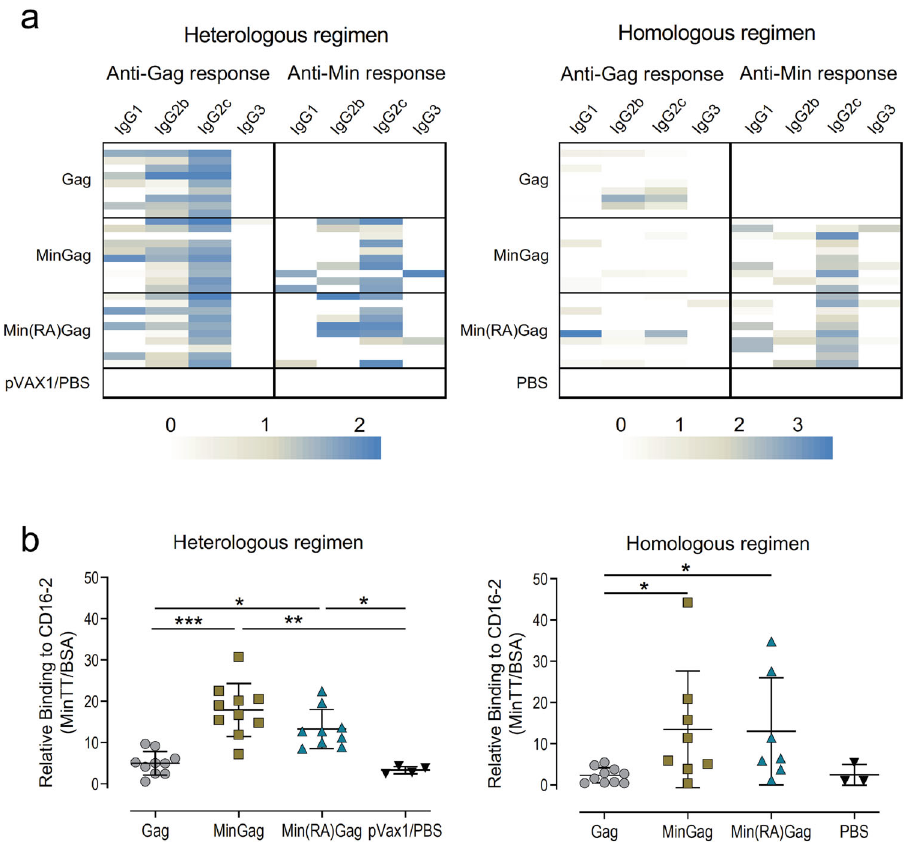
Fig. 4 Functional properties of VLP-induced humoral responses. Serum samples at week 12 from C57BL/6JOlaHsd mice vaccinated with heterologous (left panels) or homologous (right panels) regimens consisting of Gag-VLPs (grey; n = 10), MinGag-VLPs (gold; n = 10), Min(RA) Gag-VLPs (blue; n = 10) and pVAX1/PBS or PBS controls (black, n = 4). a Heatmaps of the predominant murine IgG subclasses (IgG1, IgG2b, IgG2c, or IgG3) for both anti-Gag and anti-Min humoral responses in both vaccination regimens. Each line represents one animal. b Binding to mFc γ RIV/CD16-2 by Min-speci fi c antibodies in serum from VLP-immunised mice collected at week 12. Data represented as mean ± SD of relative binding, this being the absorbance values of CD16-2 binding of each serum sample against Gp41-MinTT referred to its absorbance against BSA. Signi fi cant differences were found using a Kruskal – Wallis test with Dunn ’ s comparison (* p < 0.05; ** p < 0.01; *** p <